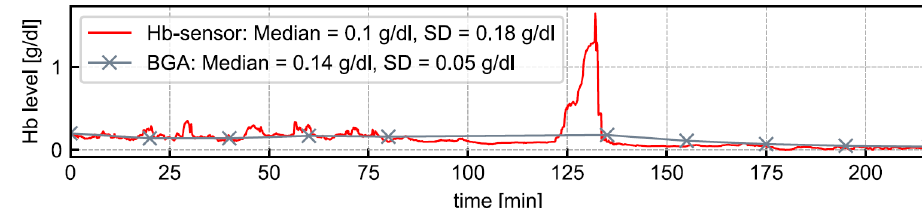
Figure 11. Measurement curve for a real patient. The blood gas analysis agrees well with the sensor readings. At approximately minute 125, the irrigation was inadvertently left off after the urine bag was emptied, resulting in a real-life example of the importance of the continuous monitoring of